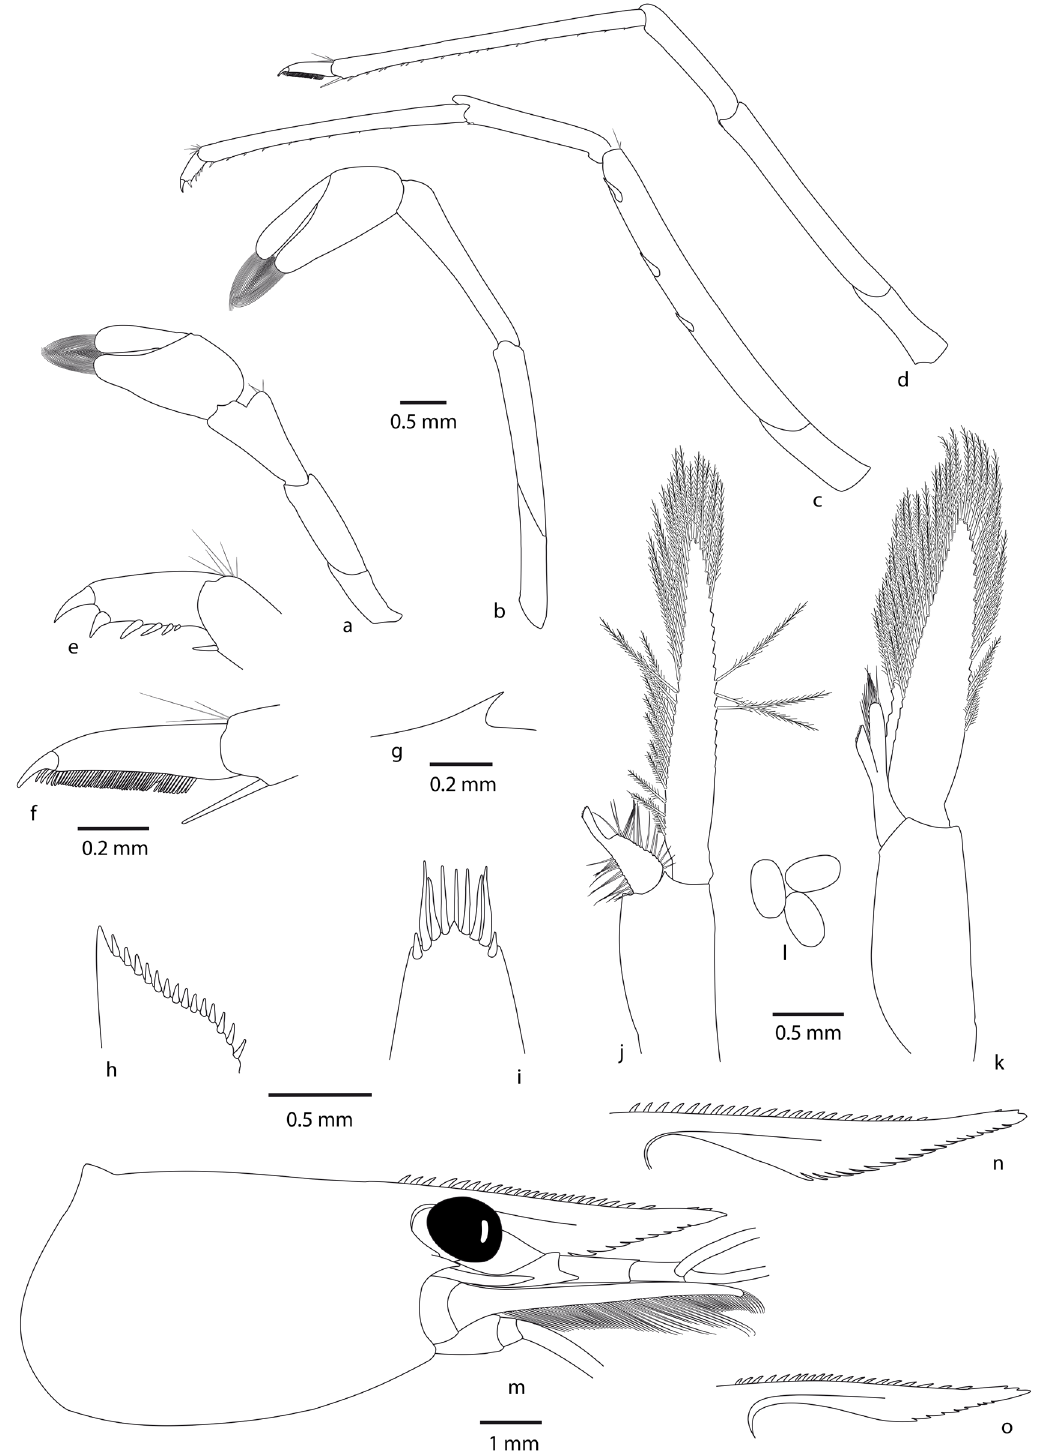
Fig. 9. Caridina pisuku sp. nov. a . First pereiopod. b . Second pereiopod. c . Third pereiopod. d . Fifth pereiopod. e . Dactylus of third pereiopod. f . Dactylus of fifth pereiopod. g . Pre-anal carina. h . Uropodal diaeresis. i . Telson. j . First male pleopod. k . Second male pleopod. l . Eggs. m . Cephalothorax. n–o . Rostrum variations. MNHN-IU-2014-20865 (a–f, l), MNHN-IU-2014-20873 (g–h, j–k), MNHN- IU-2014-20864 (m), MNHN-IU-2014-20868 (i, n) and MNHN-IU-2014-20862